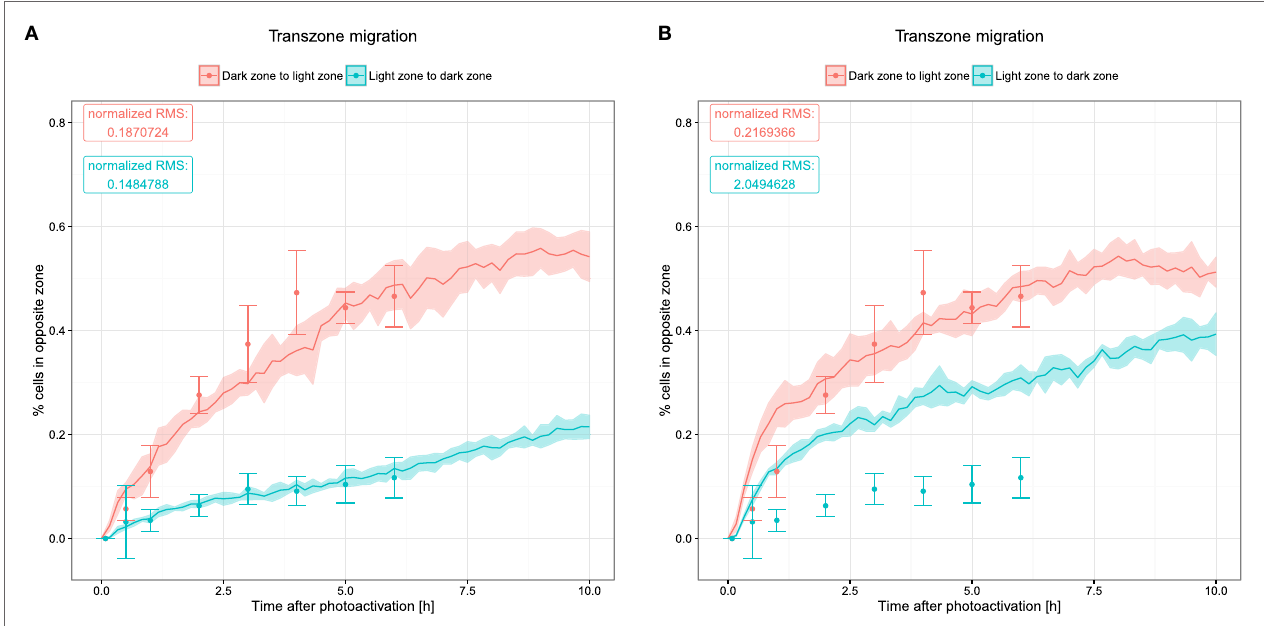
FigUre 4 | Transzone migration as measured by tracking photoactivated cells in silico . Photoactivation is performed in a defined region in either of the two zones and subsequent migration of the photoactivated cells is tracked. Displayed data show the fraction of photoactivated cells that appear in the opposite zone. Dots and error bars indicate means and SD from experimental measurements (8), lines and shaded area show mean and SD from 20 simulations. (a) Transzone migration with reference chemotaxis sensitivity parameters (see Figure 1 ); (B) transzone migration in simulations with alternative parameters for chemotaxis (see Figures 5c,D